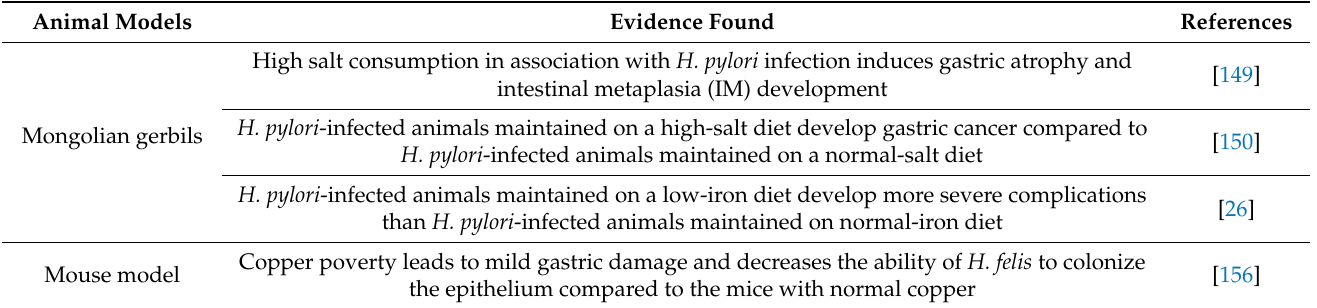
Table 4. Animal models to evaluate the role of dietary factors in gastric pathogenicity. Animal Models Evidence Found